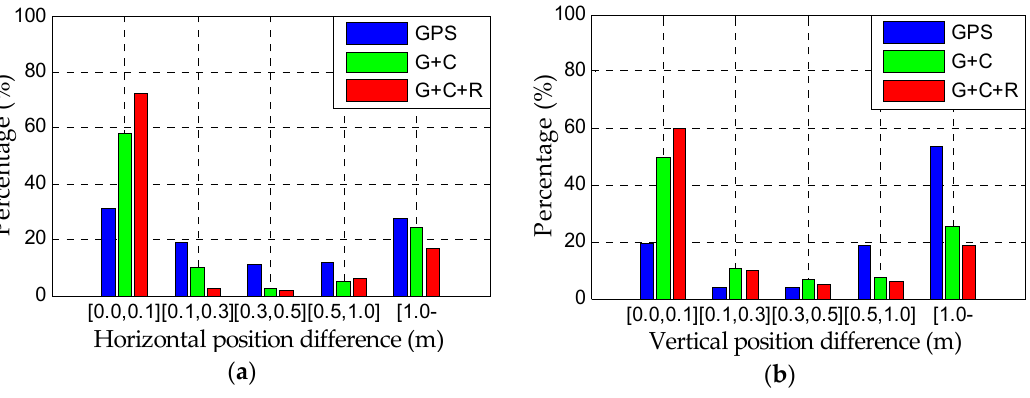
Figure 12. Distribution of the position differences of the tightly coupled RTK/INS integration for the GPS, GPS + BDS (G + C), and GPS + BDS + GLONASS (G + C + R) systems. ( a ) Horizontal; ( b ) Vertical.